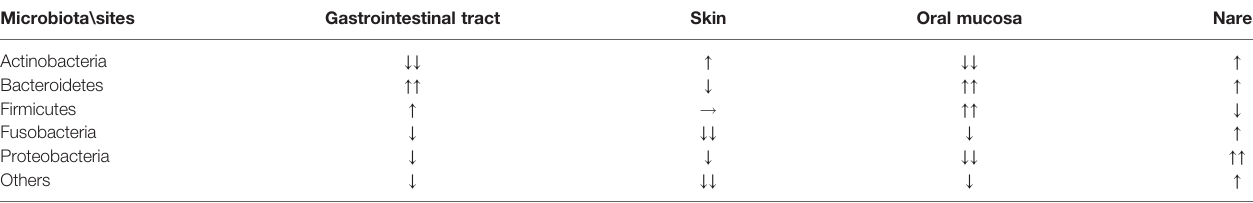
TABLE 3 | Changes in the microbial composition of various parts of the infant body from delivery to postpartum.